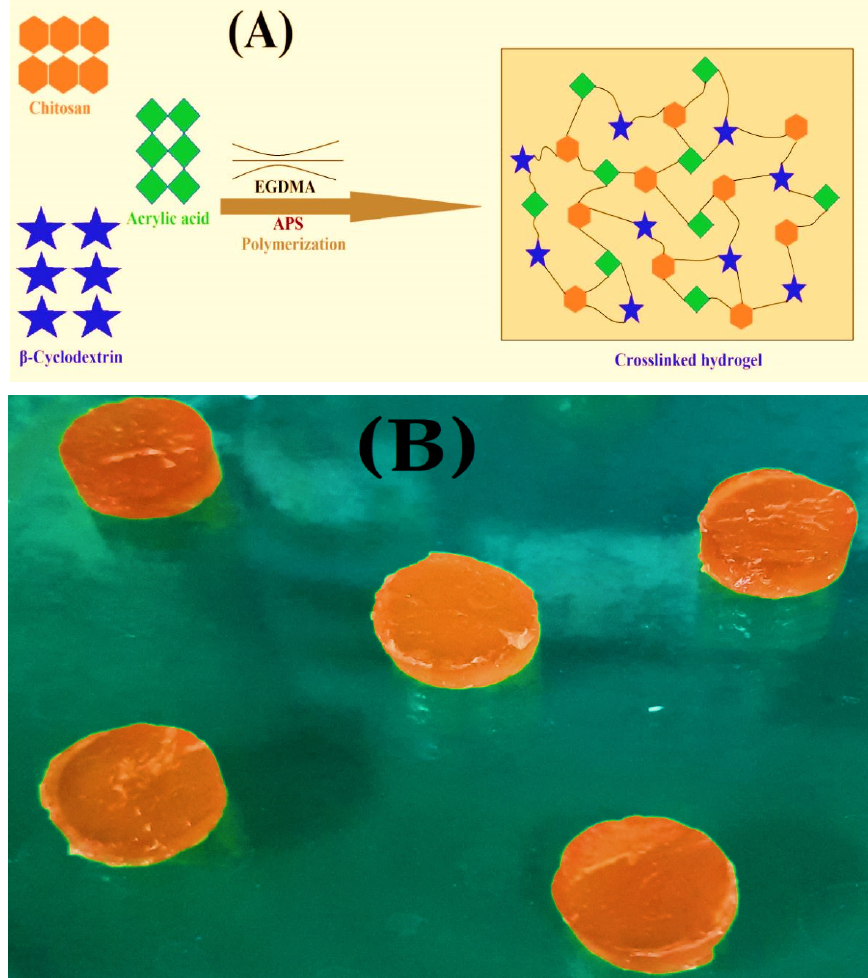
Figure 1. ( A ) Proposed schematic diagram, and ( B ) physical appearance of prepared CS/ β -CDcPAa hydrogel. CDcPAa